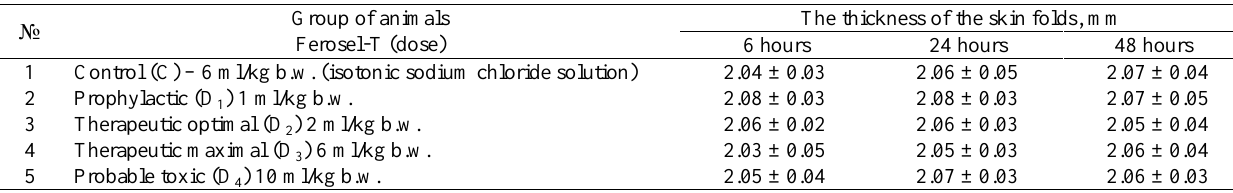
Experiment time Before